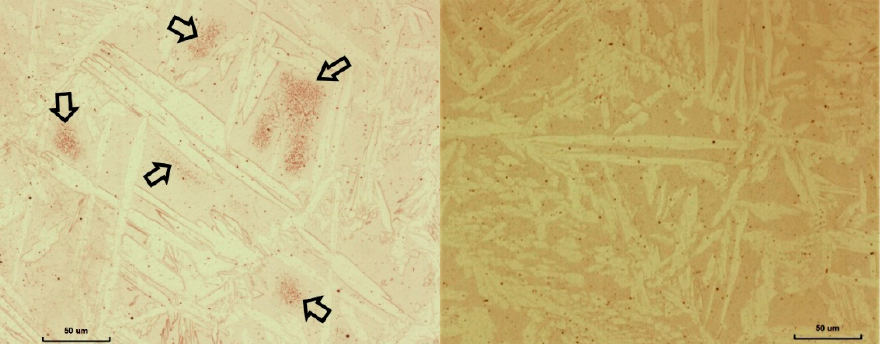
Figure 10. Influence of the grain size on the nitrides precipitation. First and second passes in GR weld cooled at the same cooling rate (38 °C/s). ( Left ) Root pass (GTAW) showing significant amounts of nitrides after only 6 s in the critical temperature range. Average ferrite grain size was 147 µ m. ( Right ) Second pass (GMAW) not presenting nitrides after 6 s in the critical temperature range. Average ferrite grain size was 87 µ m.